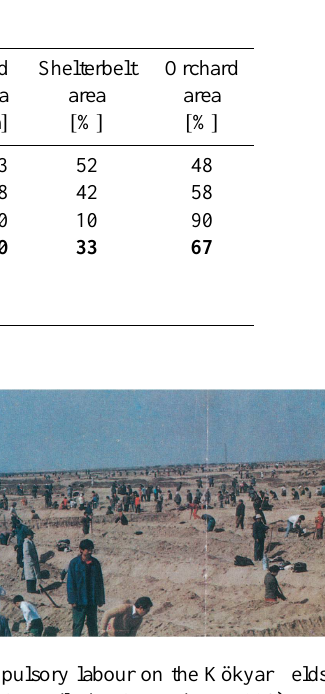
Table 1. Overview of the present four project periods of Kökyar Protection Forest. Bold numbers: sums of single project areas; italic numbers: provisional figures of the planned extent.